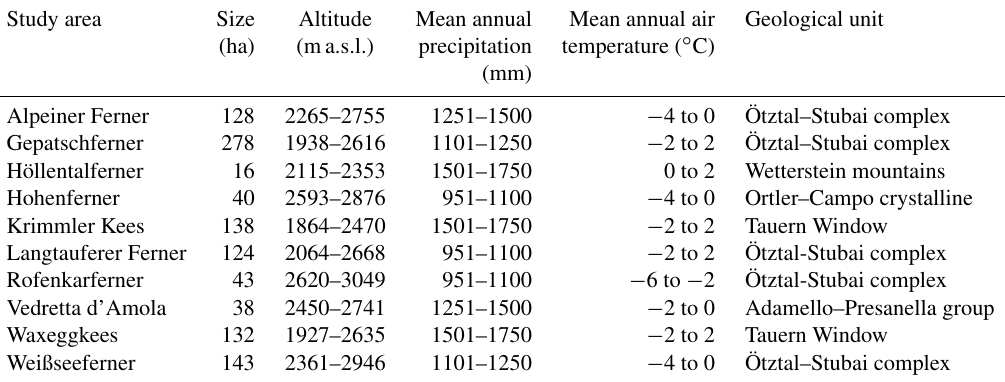
Table 1. Size, altitude (a.s.l.), mean annual precipitation, mean annual temperature, and geological unit of the glacier forefields (source of precipitation and temperature data: ZAMG et al.,